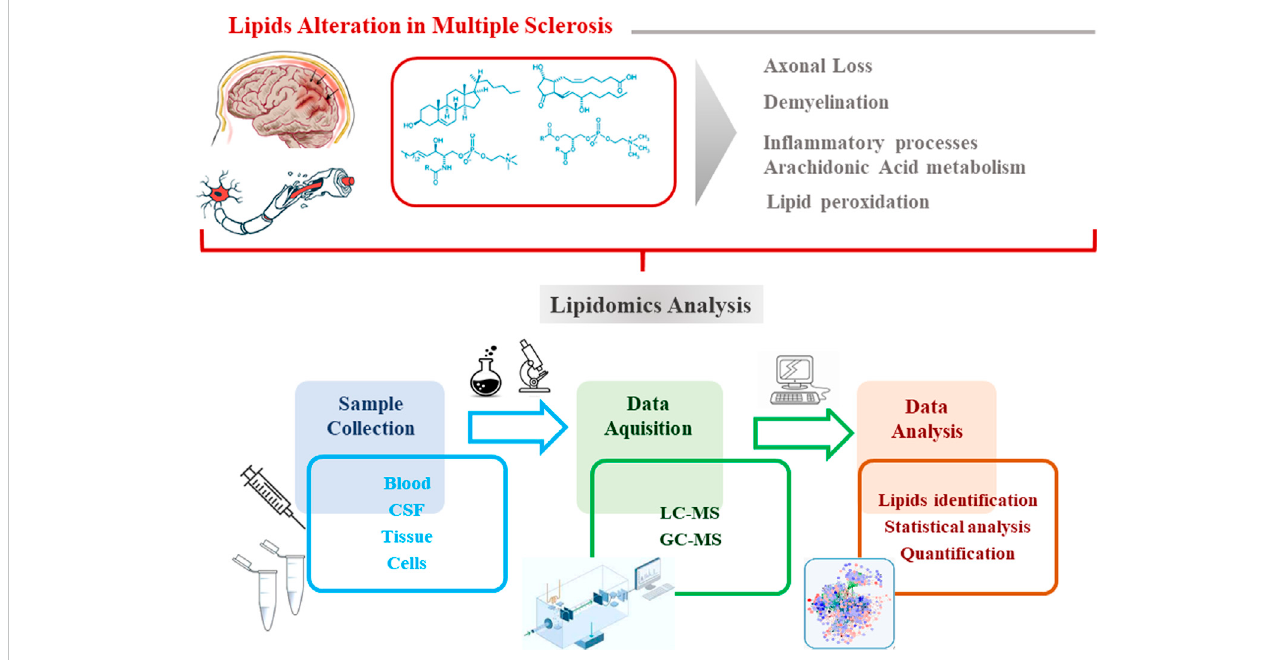
FIGURE 1 Work fl ow of a typical lipidomics experiment:sample preparation, instrumental analysis, data processing, to data interpretation.